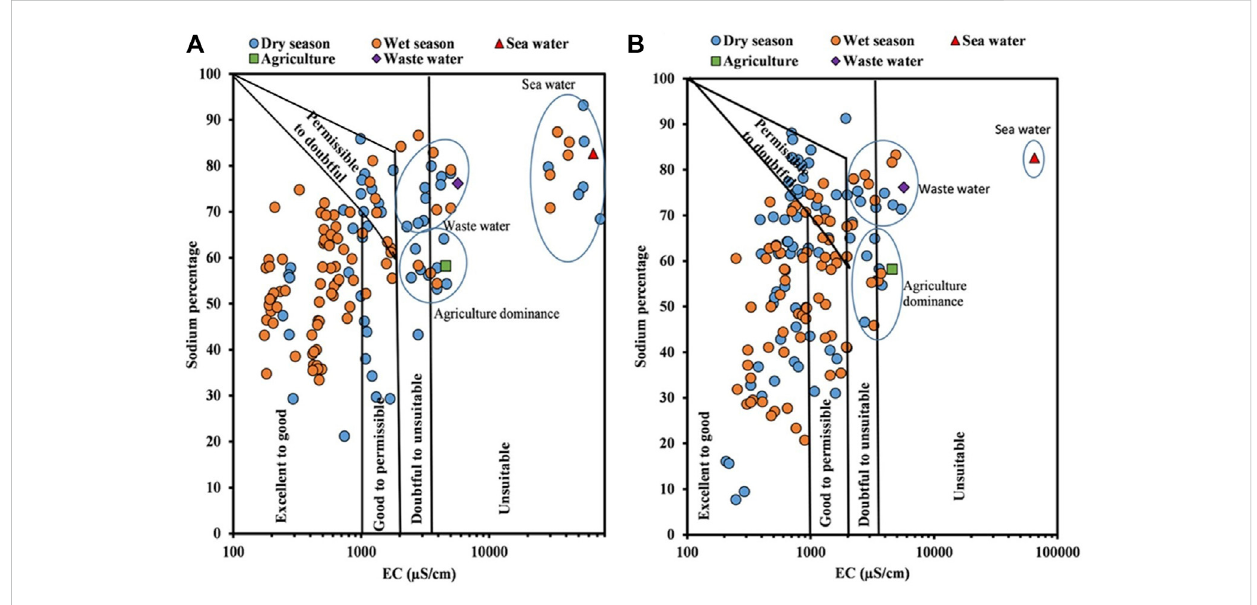
FIGURE 6 Suitability of irrigation water based on the Wilcox plot: (A) river water and (B)